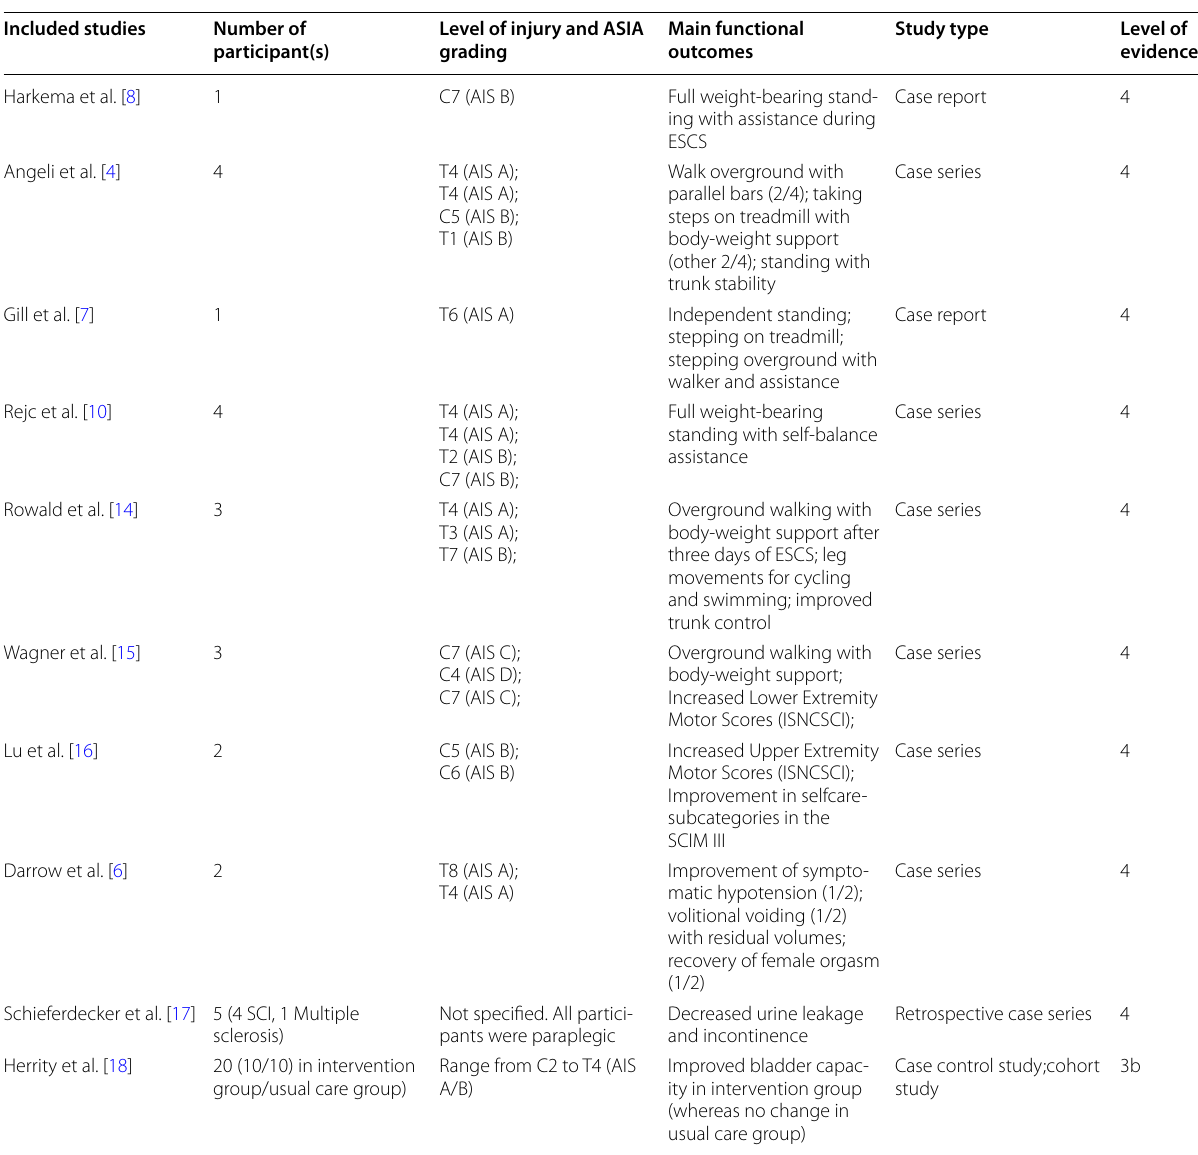
*Levels of evidence were classified according to the Oxford Centre of Evidence-Based Medicine: Levels of Evidence [19]